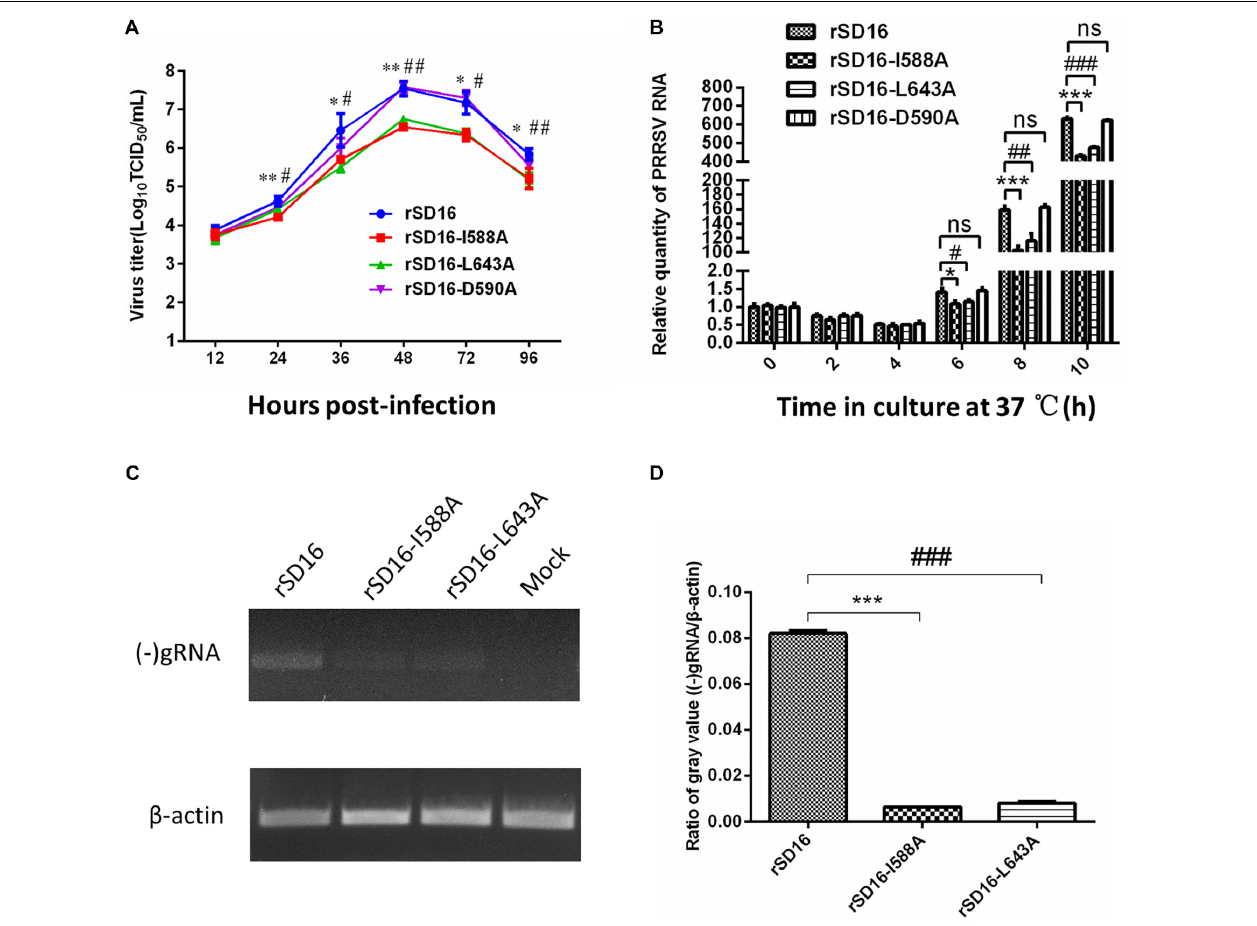
FIGURE 7 | The effect of Nsp9 mutants on PRRSV replication. (A) The growth kinetics of the rescued recombinant viruses bearing different mutations in Nsp9 were analyzed. (B) Relative levels of PRRSV RNA of recombinant viruses were further analyzed for early time points. Data represent means ± SD from three independent experiments. Asterisk (*) indicates a significant difference between rSD16 and rSD16-I588A (* p < 0.05; ** p < 0.01; *** p < 0.001). Pound ( # ) shows a significant difference between rSD16 and rSD16-L643A ( # p < 0.05; ## p < 0.01; ### p < 0.001); ns, not significant. (C) Total cellular RNAs were extracted from recombinant virus-transfected MARC-145 cells at 24 hpi, and then subjected to reverse transcribed-PCR (RT-PCR) and agarose gel electrophoresis. The mRNA level of β -actin was included as reference for total RNA input. (D) The ratio of the gray value for PCR products of ( − ) gRNA/ β -actin calculated using Image J software. Asterisk (*) indicates a significant difference between rSD16 and rSD16-I588A (*** p < 0.001). Pound ( # ) shows a significant difference between rSD16 and rSD16-L643A ( ### p <